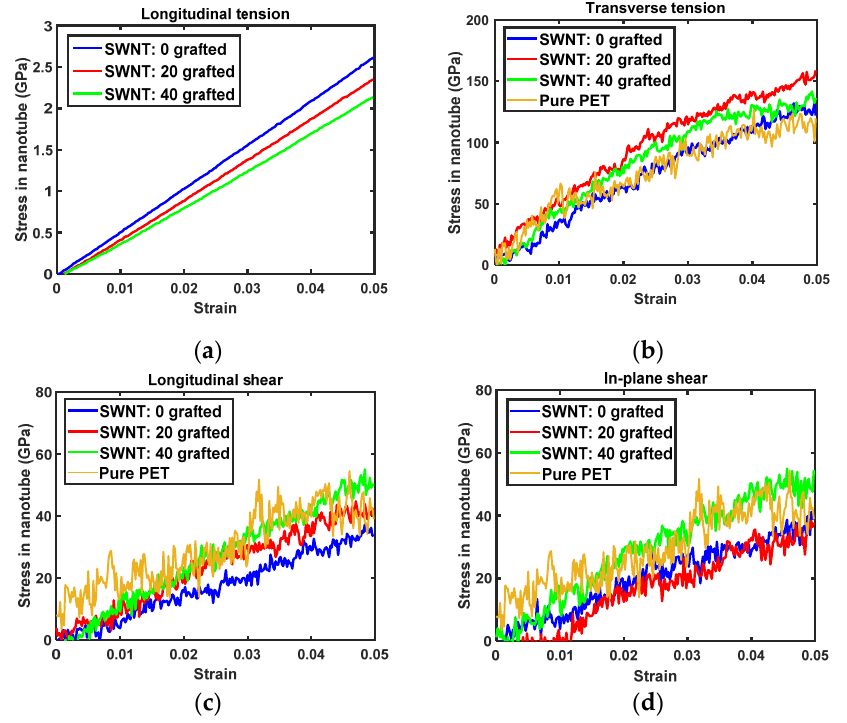
Figure 4. Transversely isotropic stress-strain relation of SWNT/PET nanocomposites: ( a ) longitudinal tension, ( b ) transverse tension, ( c ) longitudinal shearing, ( d ) in-plane shearing.